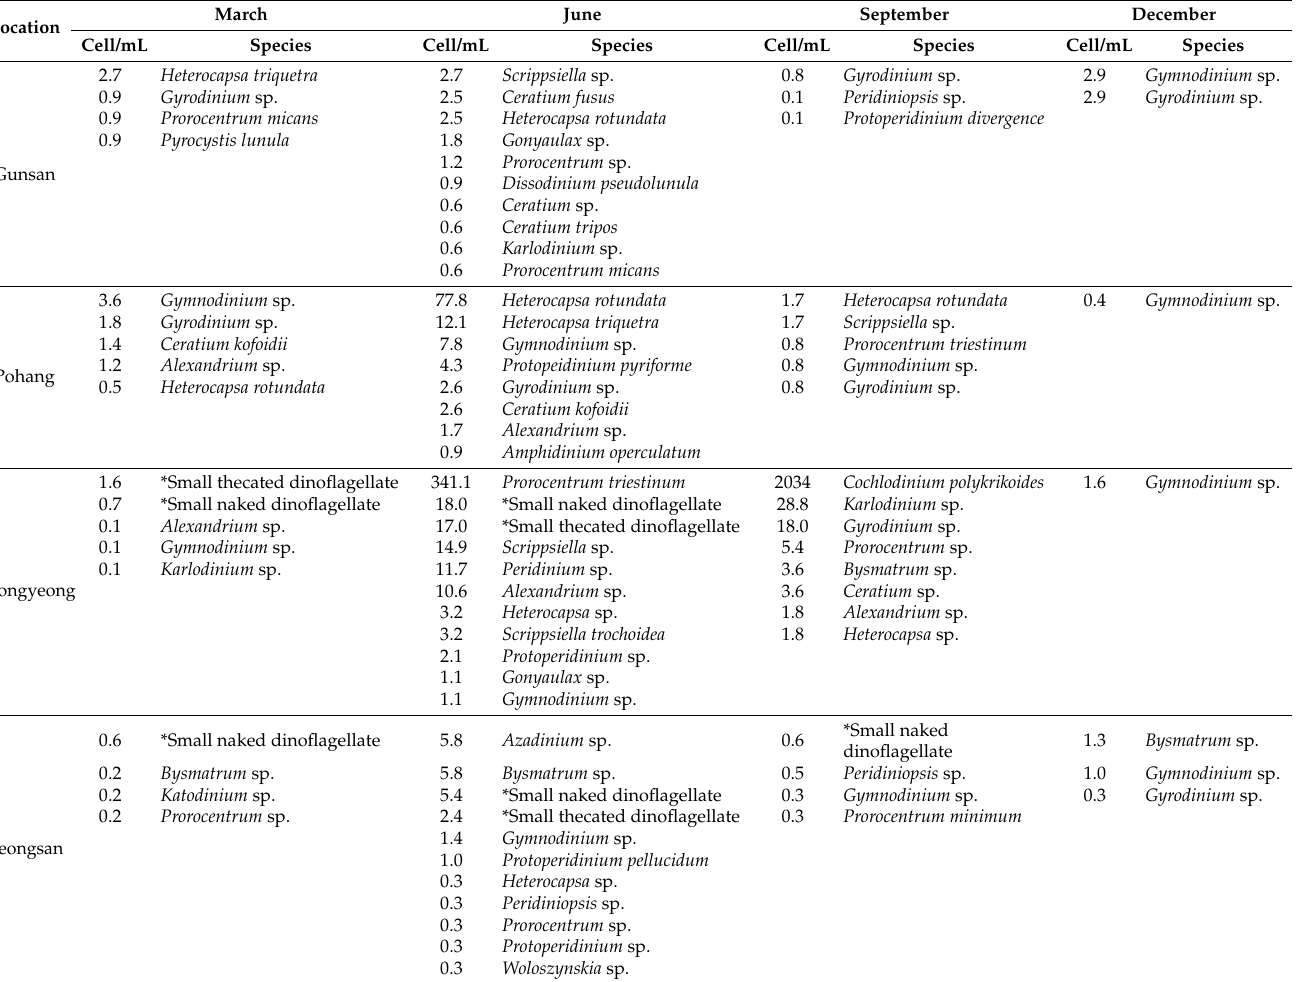
Table 2. Species composition and cell number of dinoflagellates analyzed by microscopic